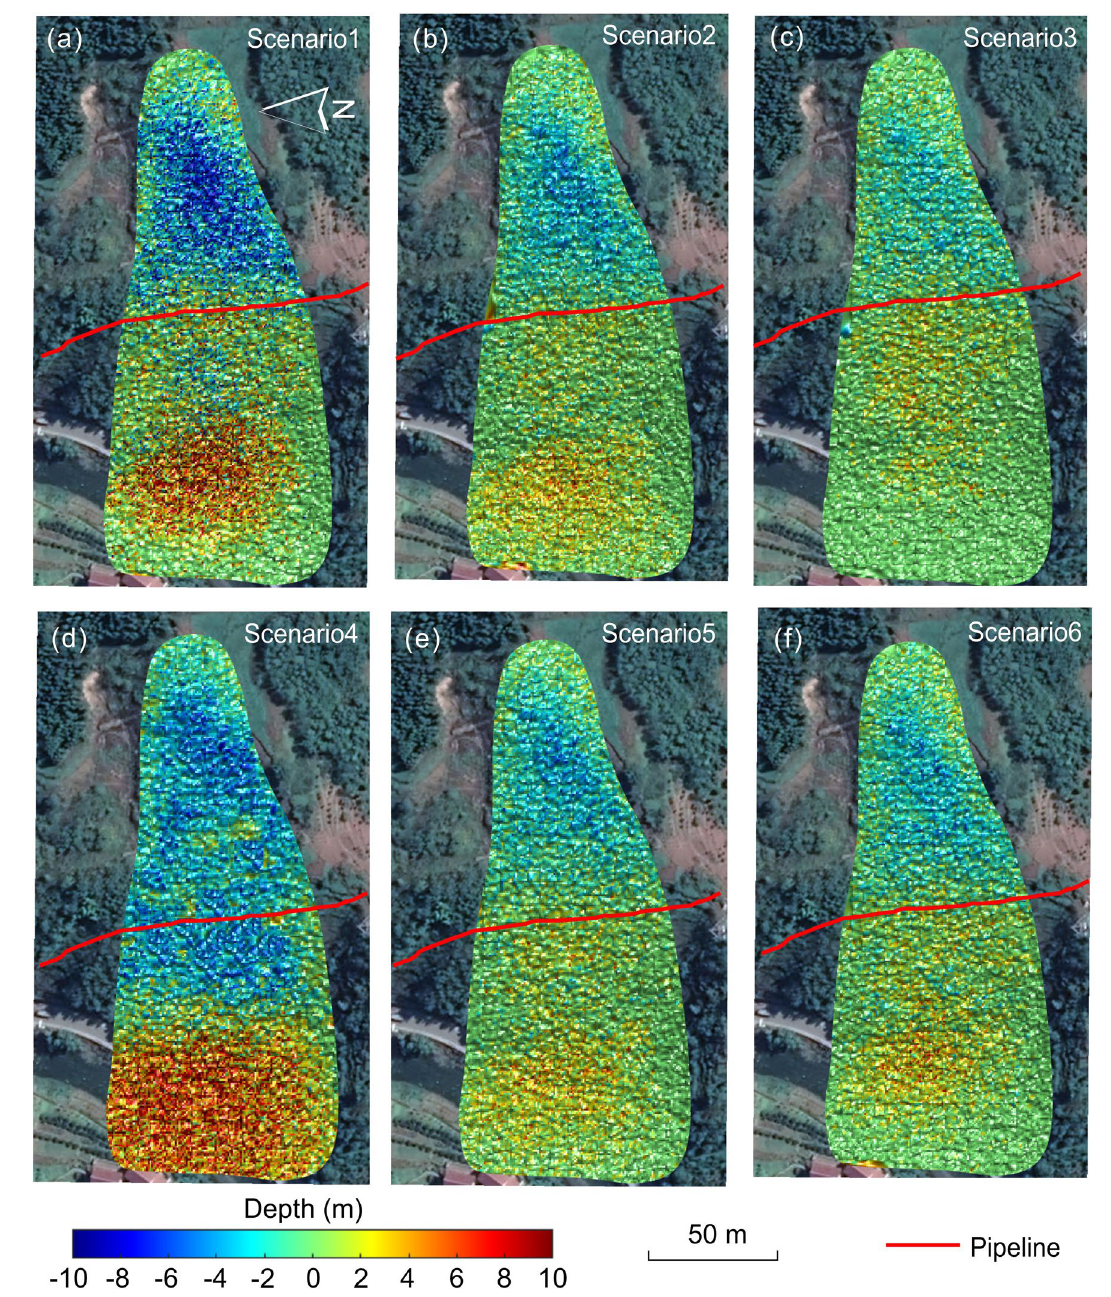
Fig. 6 Landslide erosion/accumulation depth under different simulation